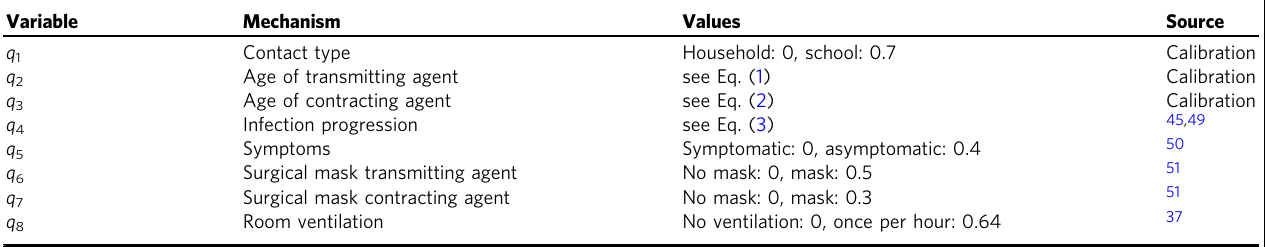
Table 1 Mechanisms q i that modify the probability of a successful transmission, p , between agents.